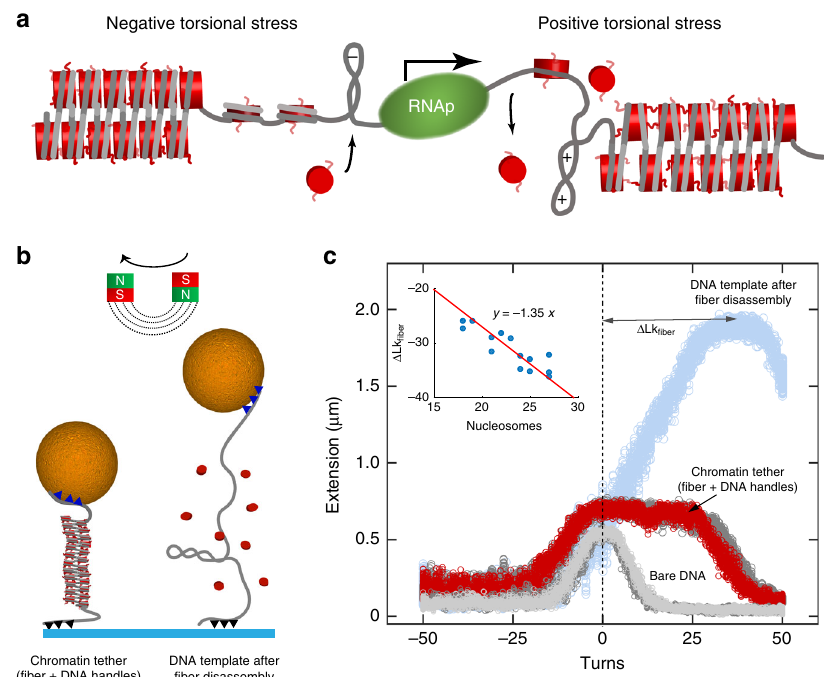
Fig. 1 Applying turns to reconstituted chromatin fi bers mimics the effect of torsional stress in vivo. a Schematic summarizing the current understanding of the response of chromatin to transcription-generated torsional stress. Progressing RNA polymerase (RNAp) generates positive DNA supercoils, ahead of the transcription bubble, that destabilize nucleosomes (red). Negative supercoils that form behind RNAp facilitate nucleosome assembly. b Schematic of single-molecule magnetic tweezers used to apply tension and torsion to reconstituted chromatin. Fibers containing (cid:4) 30 regularly spaced nucleosomes (histone octamers, red, wrapped by DNA, grey) are fl anked by (cid:4) 2 kb DNA handles for tethering to a paramagnetic bead (gold) and a glass slide (blue), respectively. The DNA handles include either multiple biotin or multiple digoxigenin moieties (triangles) in order to ensure rotational constraint. A pair of cubic magnets (red and green squares) exerts a constant stretching force on the paramagnetic bead, and hence on the tether. To apply rotations to the tethers, the magnets are rotated in either a positive (counter-clockwise) or negative (clockwise) direction. c Rotation-extension curves of DNA (grey) and a chromatin tether (red) under a force of 0.5 pN. At this force, the rotation curve of DNA handles alone (grey) is symmetric with respect to zero turns. The rotation curve of a chromatin tether (red) is asymmetric with respect to zero turns and exhibits a broad apex at positive turns. Note that this dataset obtained by rotating from negative to positive turns fully overlaps with a subsequent dataset obtained by rotating in the reverse direction (dark grey). Upon the addition of heparin to the same tether, the rotation – extension curve (blue) exhibits a maximal extension that exceeds that of the folded fi ber by a factor of three. Furthermore, the apex of the curve is shifted by + 34 turns, from which the negative linking number of the folded chromatin fi ber is deduced (Lk = − 1.4, see main text). Inset: the linking number of a chromatin fi ber, quanti fi ed by the shift between rotation – extension curves of chromatin fi bers versus bare DNA, is proportional to the number of assembled nucleosomes. The red line is a linear fi t to the data with a slope of (cid:1) 1.35 (SE = 0.02) that corresponds with the population-averaged linking number per nucleosome ( n = 14). Underlying rotation – extension curves are shown in Supplementary Fig. 1. Source data are provided as a Source Data fi